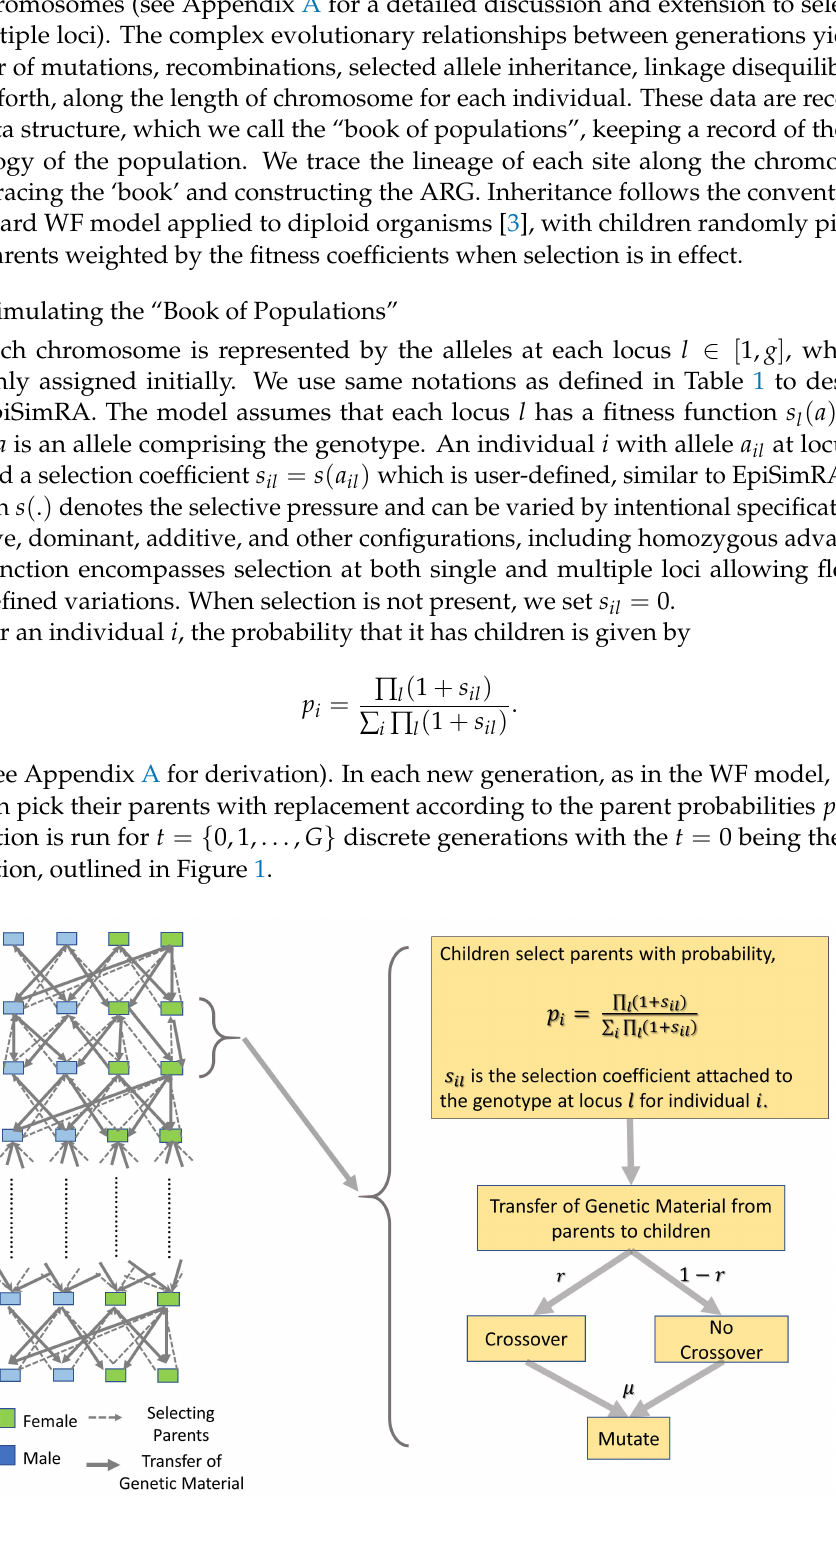
Figure 1. Schematic diagram for simulating the “book of populations” which closely resembles the biological process of